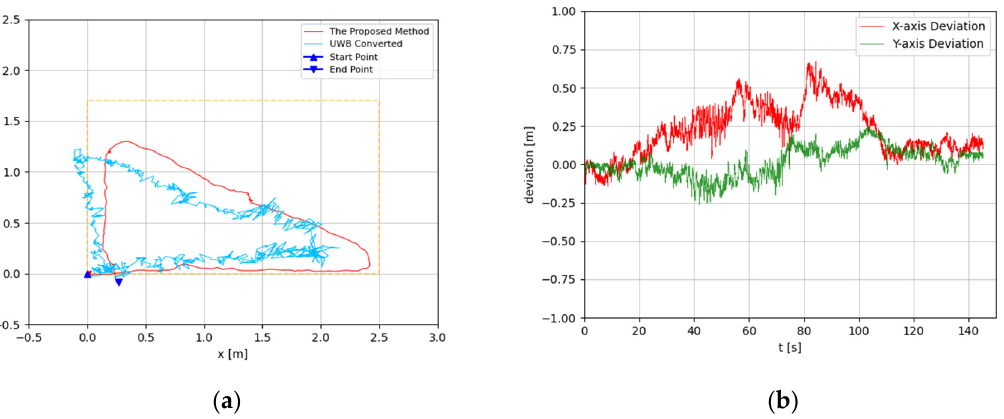
Figure 13. ( a ) Trajectory of right-triangle-shaped path in the second test; ( b ) Positioning comparison of right-triangle-shaped path in the second test.